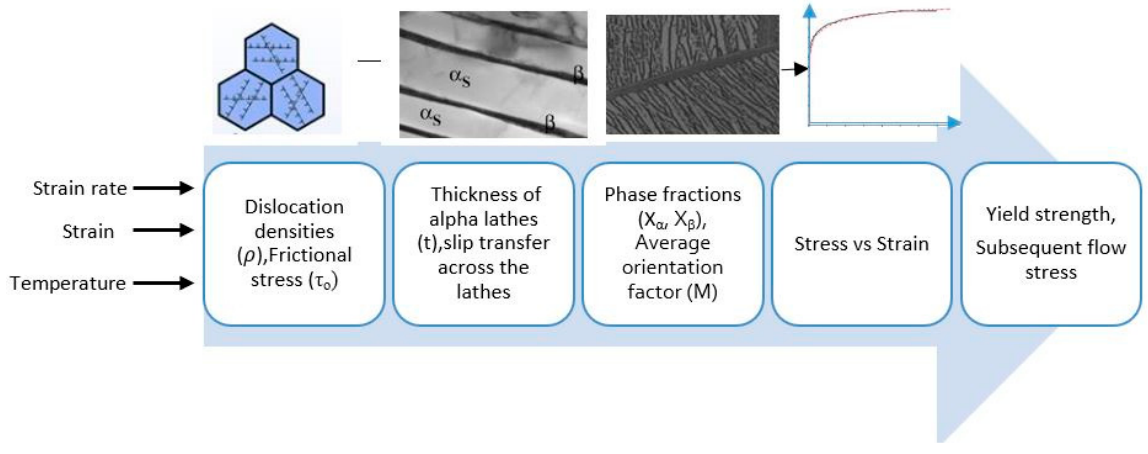
Figure 1. Microstructural variable-based constitutive model flow diagram for yield strength and flow stress.